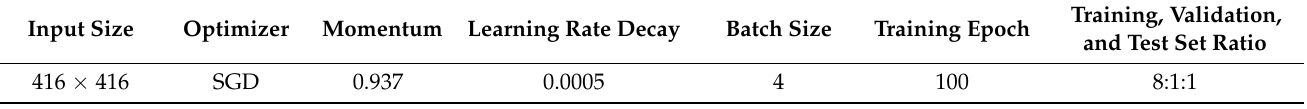
Table 1. Some initial training